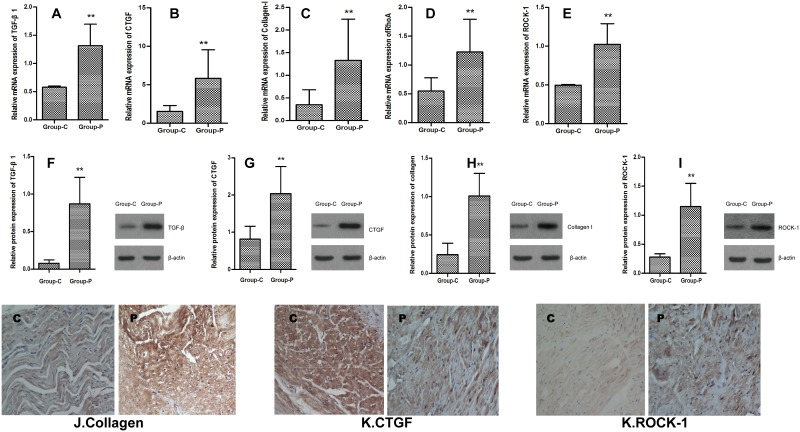
The upper panel depicts mRNA expression levels of TGF-β1 (A), CTGF (B), collagen-I (C), RhoA (D) and ROCK-1 (E) in the canine left atrium following 4 weeks of RAP. The middle panel depicts the protein expression levels of TGF-β1 (F), CTGF (G), collagen I (H) and ROCK-1 (I) in the canine left atrium following 4 weeks of RAP. The lower panel depicts the immunohistochemical results pertaining to collagen-I (J), CTGF (K) and ROCK-1 (L) in the hearts (×400). C, control group; P, pacing group. *P<0.05, **P<0.01 vs group C. (n = 6 for Group C, n = 9 for Group P).